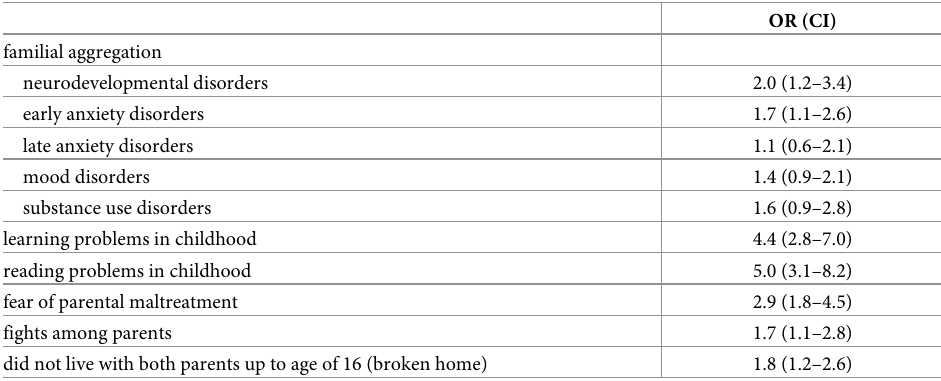
Table 5. PsyCoLaus: Familial aggregation of mental disorders and psychosocial factors related to stuttering. Odds ratios and confidence intervals, adjusted for sex (95%).